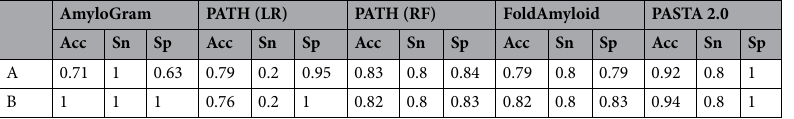
Table 5. Consensus between annotations obtained from bioinformatics methods and IR microscopy (Accuracy Acc , Sensitivity Sn , Specificity Sp ). Presented results are for: (A) all 24 sequences from the test set , (B) only 17 sequences from the test set , which turned out misannotated in